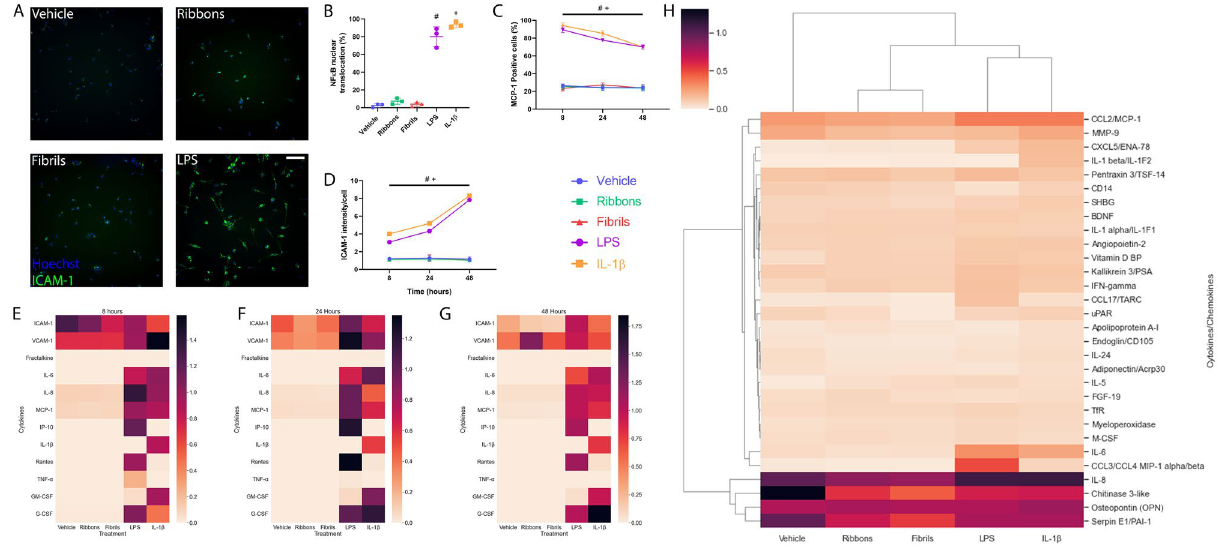
Figure 2. Inflammatory responses of microglia treated with two α-syn preparations. Inflammatory responses of primary human brain microglia when treated with vehicle, ribbons, fibrils (100 nM), LPS (10 ng/mL) and IL-1β (10 ng/mL). ( A ) Representative immunocytochemistry images of ICAM-1 induction after 48 h treatment Scale bar = 200 µm. Immunocytochemistry quantification of ( B ) NF-κB nuclear translocation after 1 h treatment, ( C ) MCP-1 and ( D ) ICAM-1 induction after times indicated ( n = 3, mean ± SD ). Microglia were cultured and treated with vehicle, two different α-synuclein preparations (100 nM), LPS (10 ng/mL) and IL-1β (10 ng/mL) before conditioned media were taken and cytokine secretion analysed by cytometric bead array. Heatmap analysis of cytokine secretion of microglia after treatment at ( E ) 8 h, (F) 24 h and ( G ) 48 h ( n = 3). Microglia were cultured and treated with vehicle, two different α-synuclein preparations (100 nM), LPS (10 ng/mL) and IL-1β (10 ng/ mL) for 24 h before conditioned media were taken and cytokine secretion measured using a Proteome Profiler Human XL Cytokine Array Kit. Clustered heatmap analysis ( H ) of the top 30 secretions in microglia ( n = 1, epilepsy case). #LPS, + IL-1β vs vehicle p < 0.05; one way ANOVA with Tukey’s multiple comparisons test or two way ANOVA with Tukey’s multiple comparisons